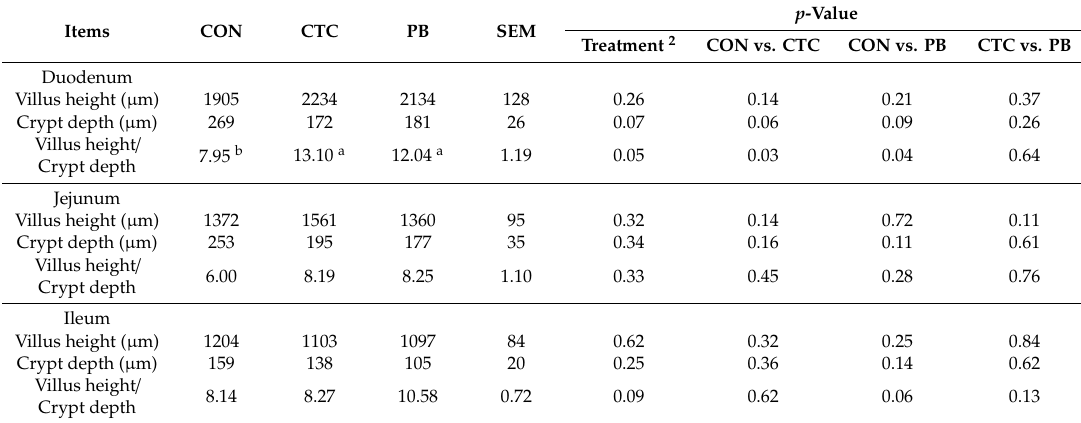
Table 7. E ff ects of probiotics on intestinal morphology of broilers (day 42) 1 .